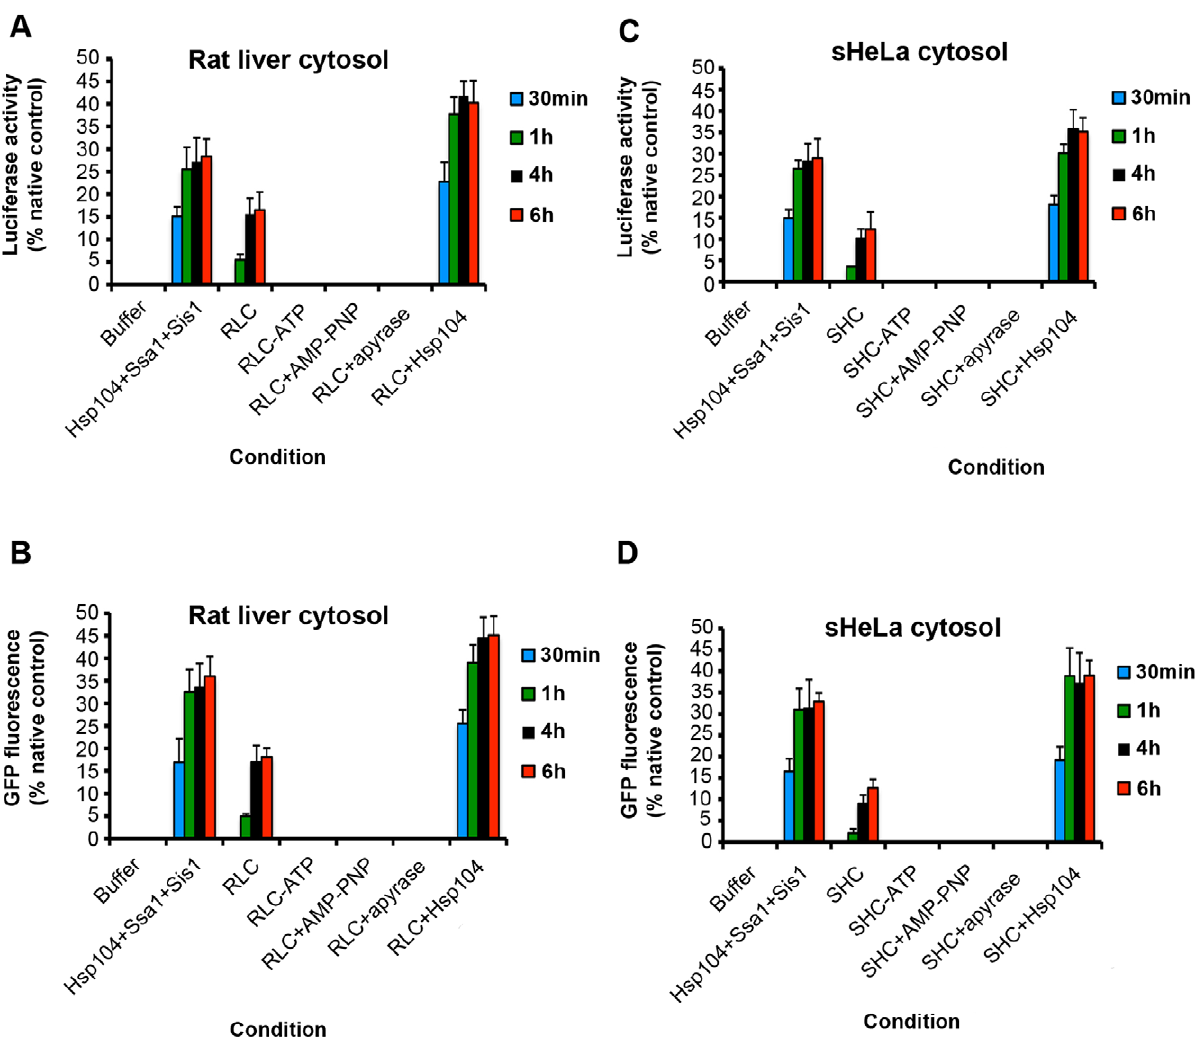
Figure 1. Mammalian cytosol contains an ATPase-dependent disaggregation machinery. ( A, B ) Urea-denatured luciferase aggregates (50 nM) ( A, C ) or heat-denatured GFP aggregates (0.45 m M) ( B, D ) were incubated for 30 min (blue bars), 1 h (green bars), 4 h (black bars), or 6 h (red bars) at 25 u C in buffer plus ATP (5 mM) and ATP-regeneration system without or with the indicated combination of Hsp104 (1 m M), Ssa1 (1 m M), Sis1 (1 m M), RLC (10 mg/ml) ( A, B ), or SHC (10 mg/ml) ( C, D ). In the indicated reactions, ATP was omitted or replaced with AMP-PNP. Alternatively, ATP was included but the ATP-regeneration system was replaced with apyrase. Disaggregation and reactivation of luciferase was monitored by luminescence. Luminescence measurements were converted into reactivation yield (% of the maximum recoverable luciferase activity) by comparison to the luminescence of known quantities of soluble, native luciferase ( A, C ). Disaggregation and reactivation of GFP was monitored by fluorescence. Fluorescence measurements were converted into reactivation yield (% of the maximum recoverable GFP fluorescence) by comparison to the fluorescence of known quantities of soluble, native GFP ( B, D ). Values represent means 6 SEM (n=3).